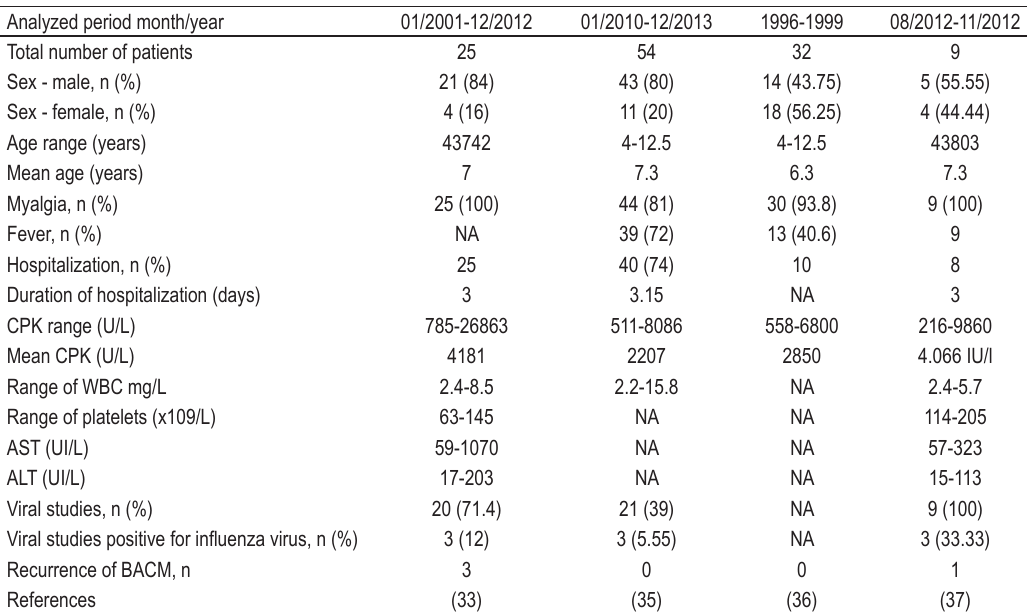
TABLE 1. Summary clinical characteristics of children with BACM Analyzed period